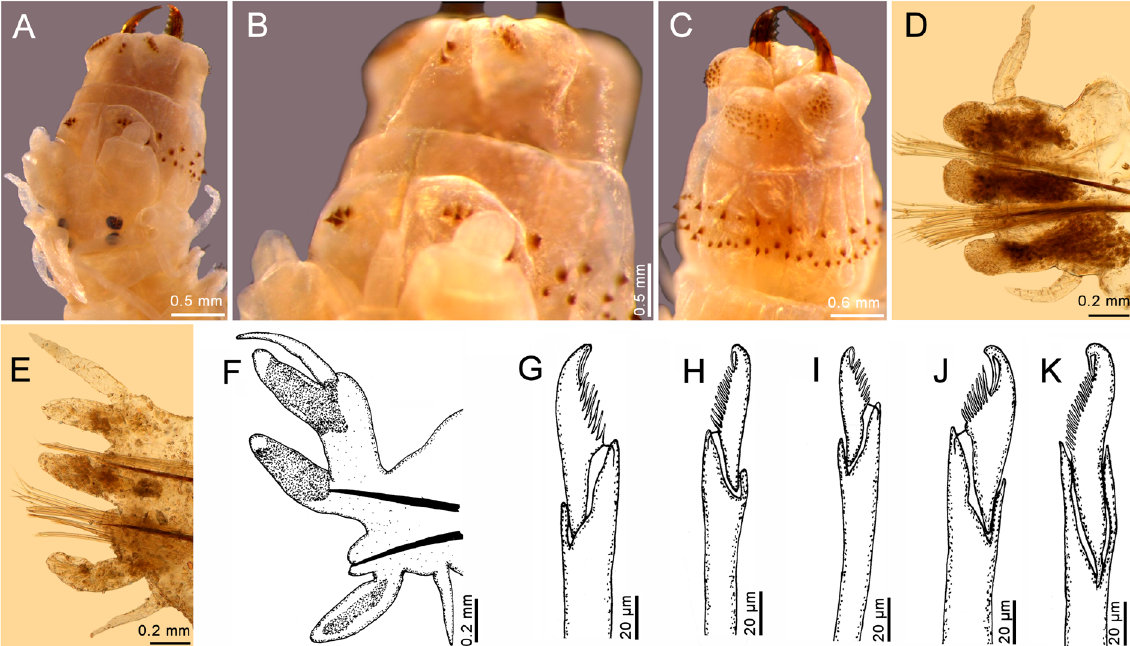
Fig. 7. Nereis callaona Grube & Kröyer in Grube, 1857, holotype (NHMD 109278). A . Anterior end, oblique dorsal view. B . Same, close-up of pharynx. C . Pharynx, oblique ventral view. D . Chaetiger 10, right parapodium, anterior view. E . Chaetiger 31, right parapodium, anterior view. F . Chaetiger 61, right parapodium, anterior view. G . Chaetiger 10, neuropodial supracicular heterogomph